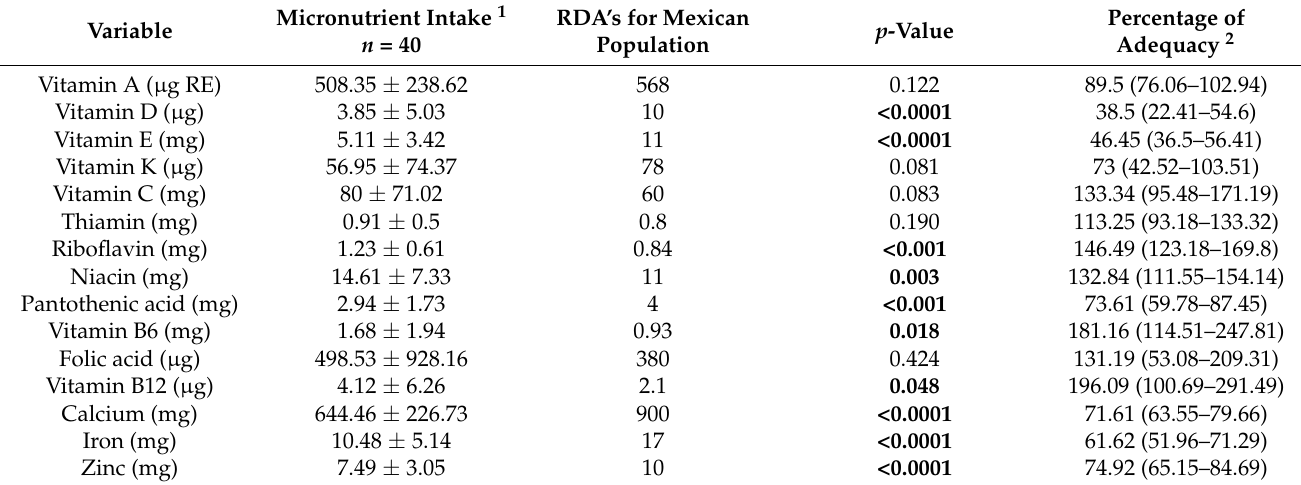
Table 2. Dietary micronutrient intake and comparison with RDA’s for the Mexican population.